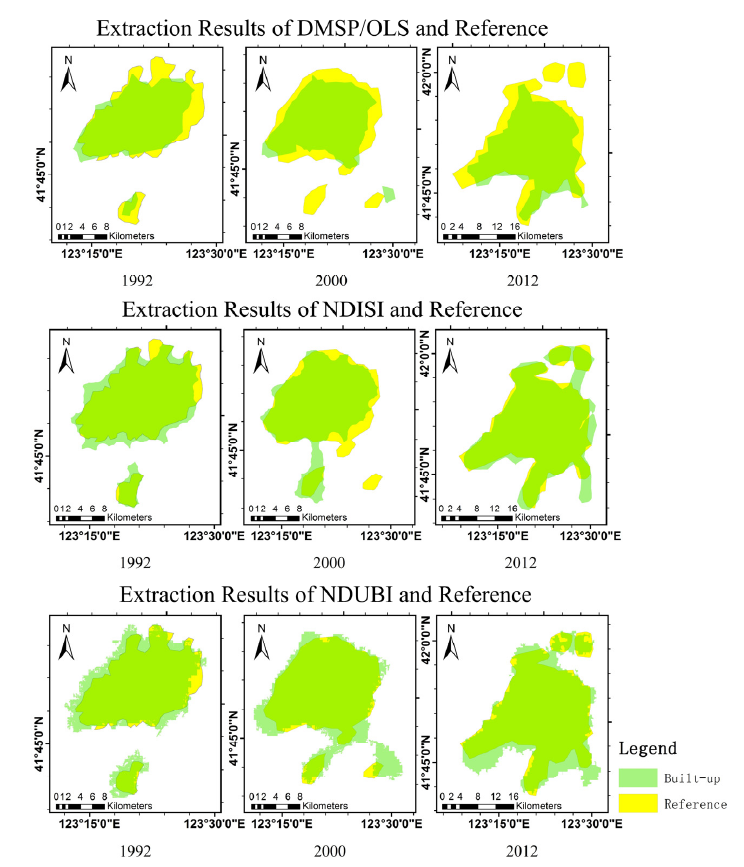
Figure 7. The build-up areas extraction results of the three